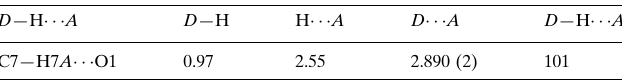
Hydrogen-bond geometry (A˚ , (cid:1)